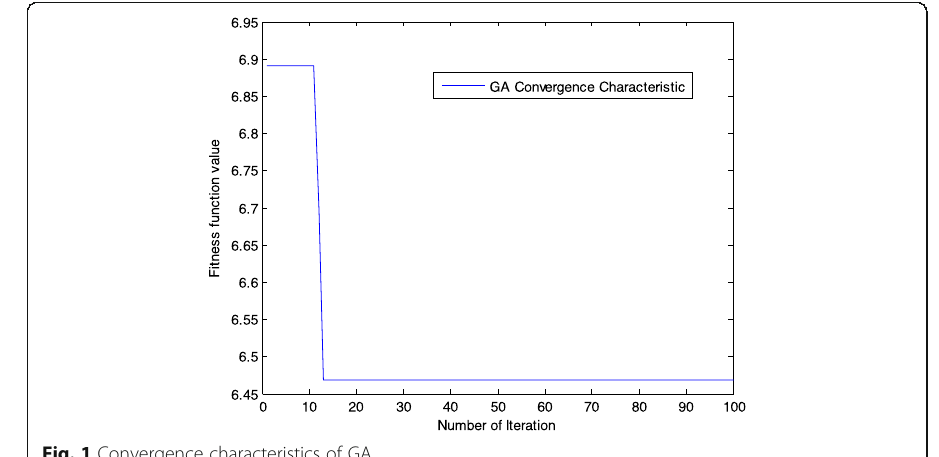
Fig. 1 Convergence characteristics of